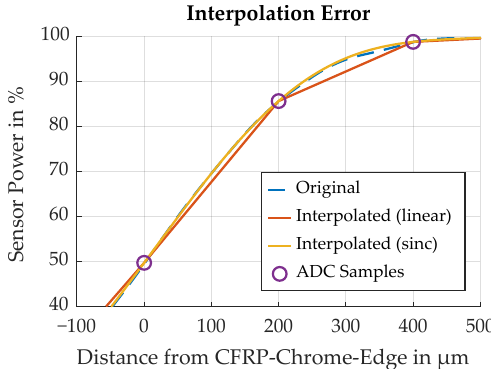
Figure 29. A simulation of sampling the edge transition function at 5 MSps and subsequent